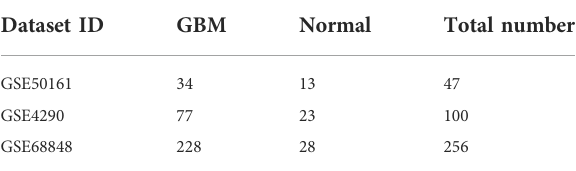
TABLE 1 Statistics of the three microarray databases.